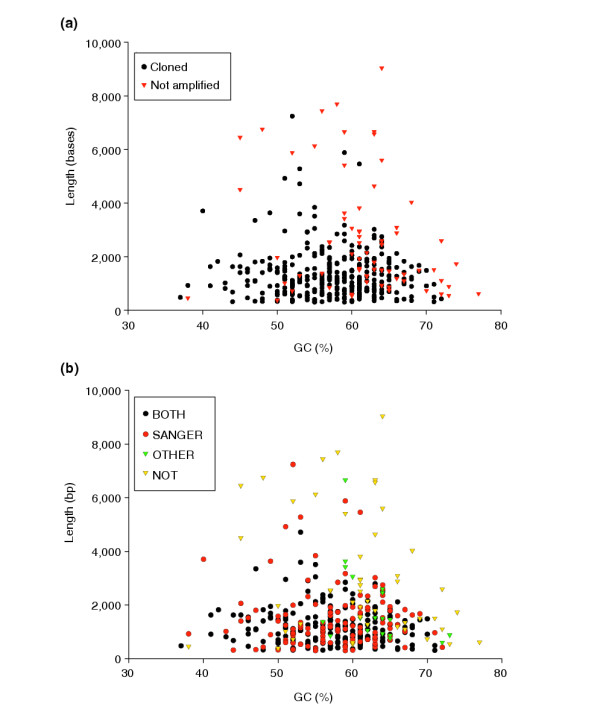
Sequence characteristics of cloned ORFs. (a) Plot of the distribution of the 398 chromosome 22 ORFs by GC content (%) and length (bases). Closed circles are the 331 ORFs that were isolated as acceptable clones (278) or as clones with the correct ORF but currently with a problem in the sequence (53). Dotted circles are the rest of the ORFs which were not amplifiable or clonable (67). (b) Overlap of chromosome 22 ORF clones isolated here with cDNA collections. Analysis of GC content and length for 398 chromosome 22 ORFs, split according to whether the gene has been isolated only by the strategy described here (SANGER, red circles), only in the cDNA collections (OTHER, green triangles), in both (BOTH, black circles), or not at all (NOT, yellow triangles).